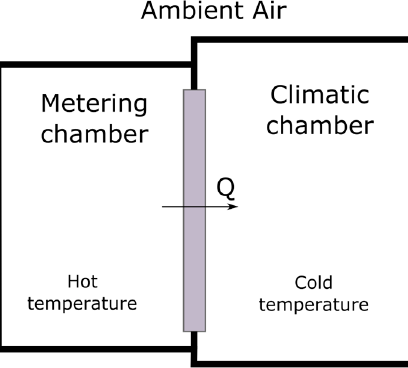
Figure 1. A simplified hot-box main parts schema.